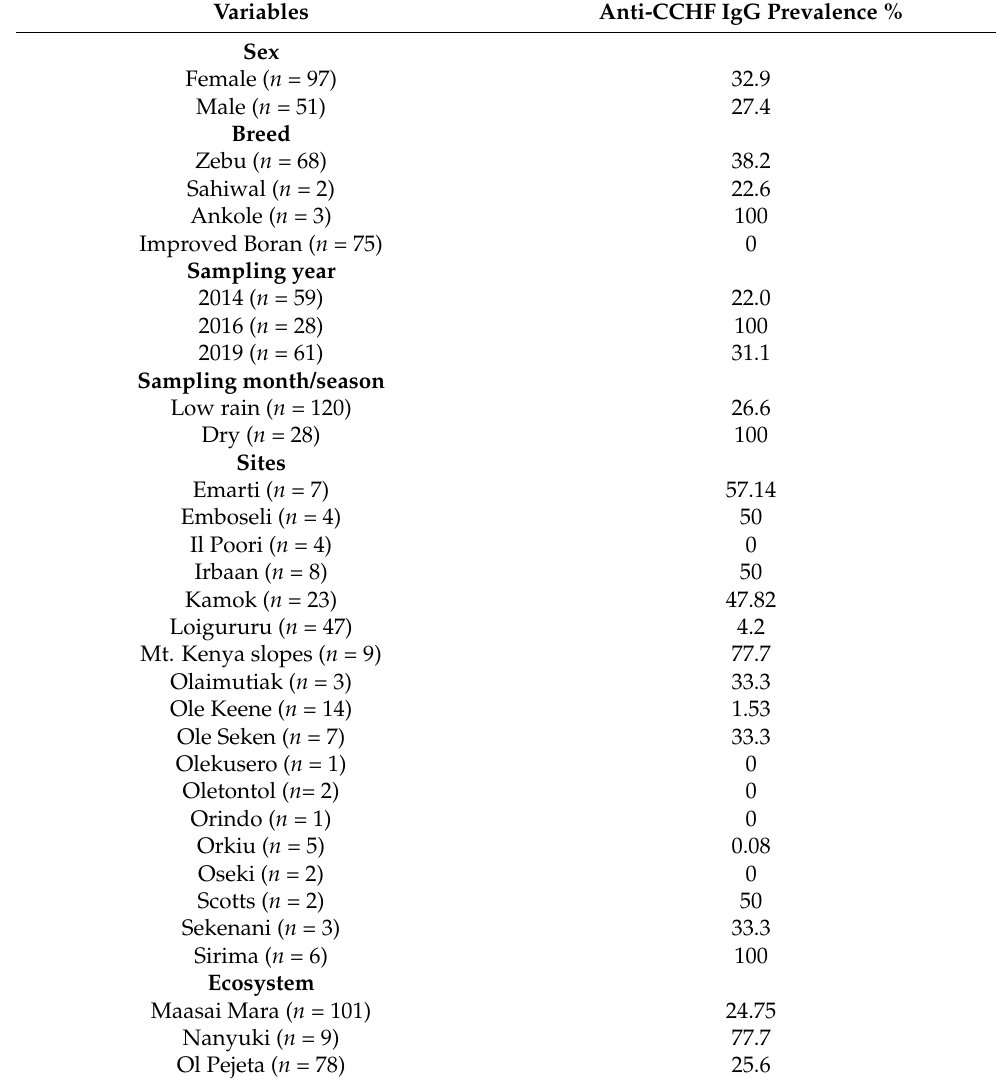
Table 1. Animal and other categorical variables of descriptive CCHF serological outcomes, Kenya.